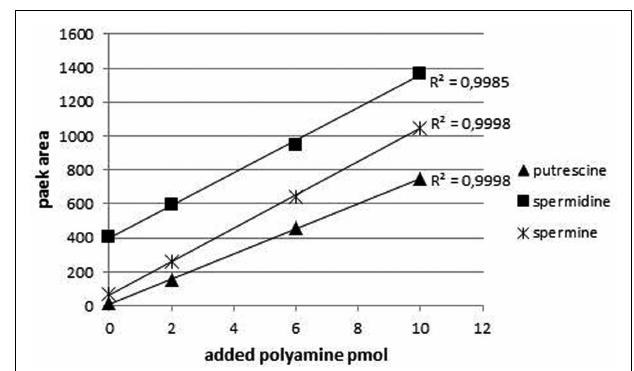
FIGURE 3 |Typical calibration curves for the PAs of interest quantified by standard addition method. Leaf extracts were supplemented with different amounts of PAs.The curves are linear and the correlation coefficient for all three compounds is above 0.999.The ordinate indicates the fluorescence intensity: excitation at 265nm; emission at